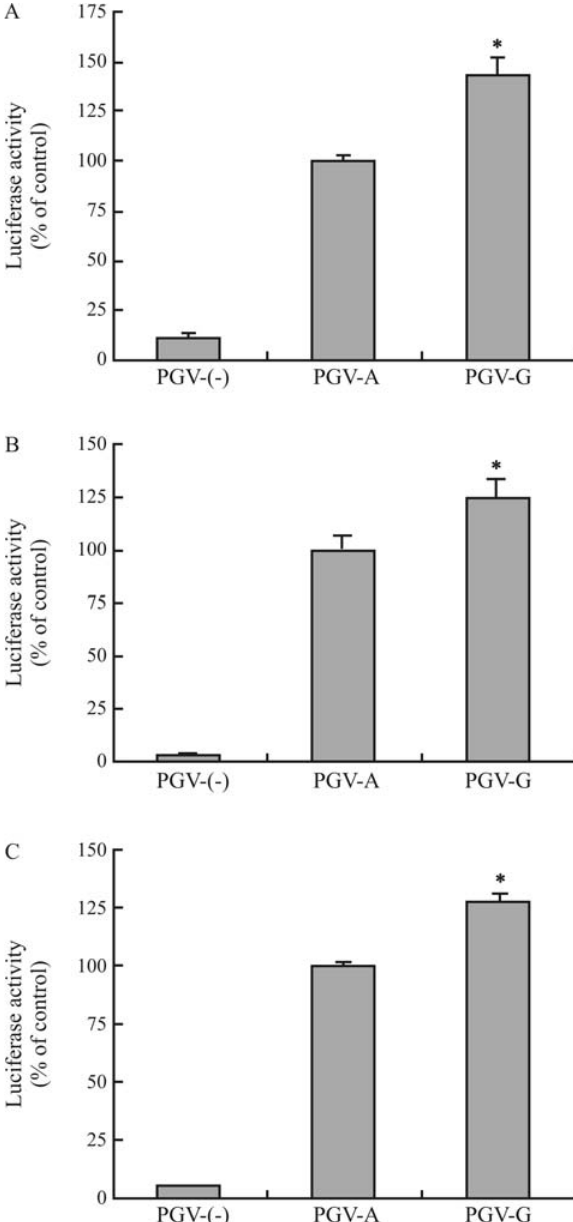
Figure 7 - Effects of the p16 INK4a polymorphism at position -191 on luci- ferase activity in different cell lines. (A-C) Colo320DM (A), U251 (B), and T98G (C) cells were transfected with the indicated vector constructs of PGV-(-), PGV-A, and PGV-G. The transfected cells were cultured for 24 h, and luciferase activity was determined. Data are shown as percent- ages of values obtained from the PGV-A transfectants and are expressed as the mean (cid:5) SEM (n = 8). *: Significant difference compared with the PGV-A